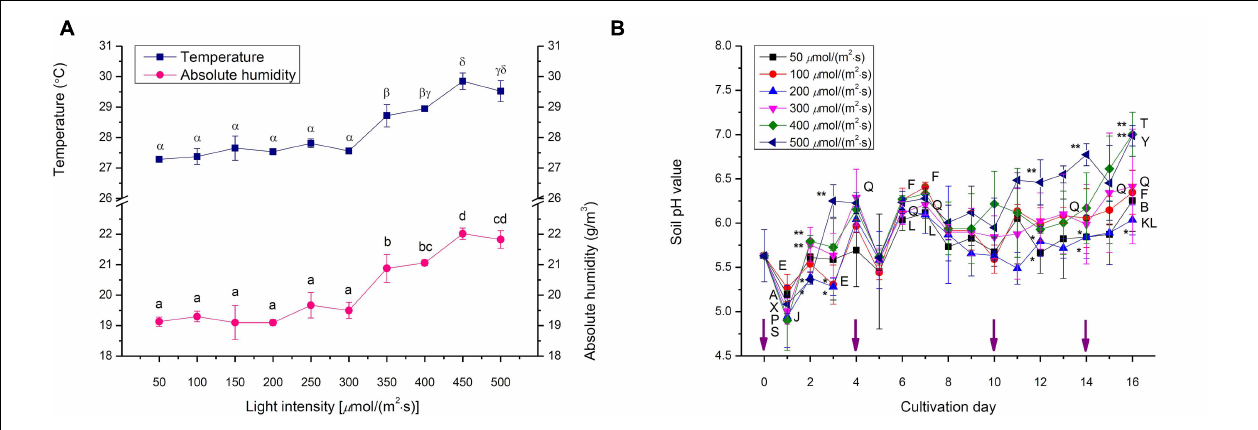
FIGURE 3 | The environments of (A) temperature and absolute humidity, as well as (B) soil pH of choy sum seedlings grown under different white LED light intensities and days. Different Greek alphabets ( α , β , γ , and δ ) and lower cases (a, b, c, and d) showed significant differences of temperature and absolute humidity across all the light intensities tested, respectively. Different upper cases (A, B/E, F/J, K, L/P, Q/S, T/X, and Y) indicated significant differences of soil pH values among 50, 100, 200, 300, 400, and 500 µ mol/(m 2 · s), respectively. The asterisks (* and **) indicated significant differences of soil pH values under specific light intensities on the identical day ( n = 3, one-way ANOVA; Tukey multiple comparison; p < 0.05). The purple arrows indicated the irrigation days.